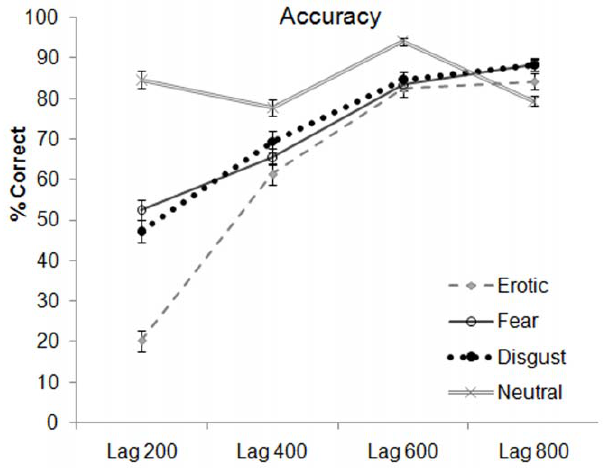
Figure 2. Accuracy scores for each emotion by time lag. Error bars represent standard error of the mean.